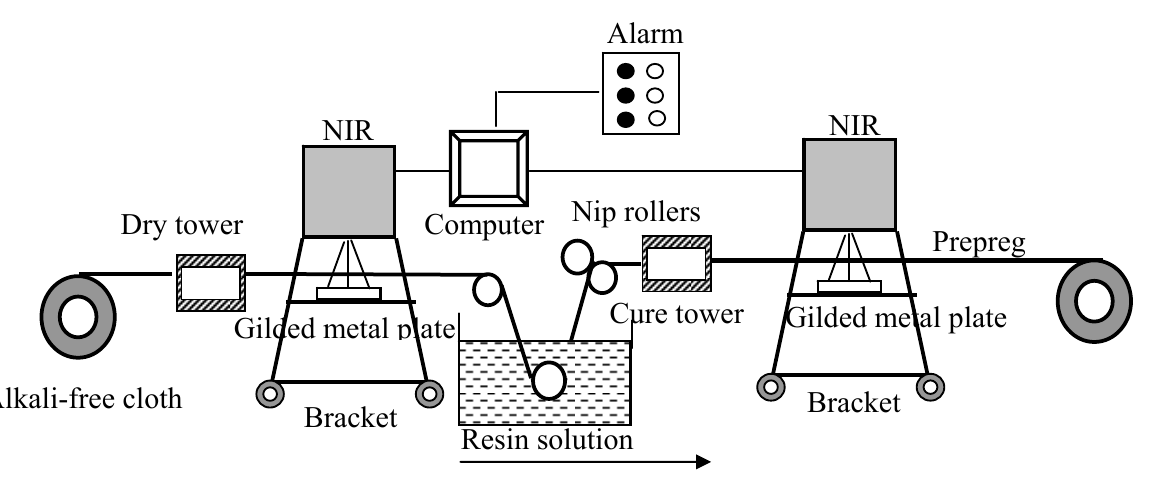
Figure 7. Schematic diagram of NIR monitoring manufacture process of prepreg